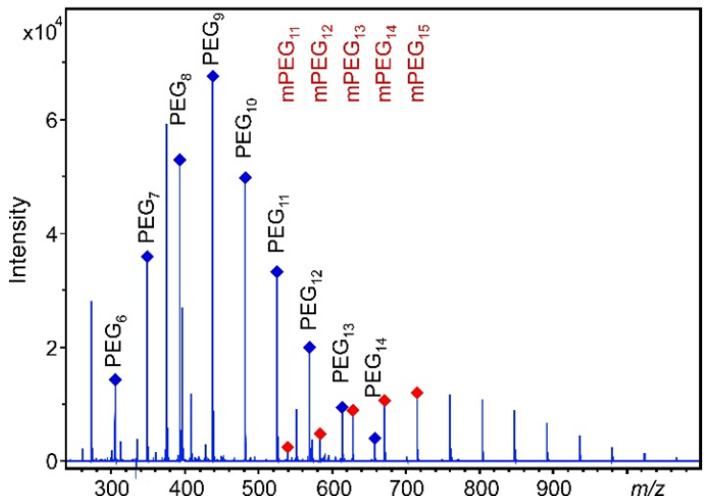
Figure 3. MALDI-TOF spectrum of a pre-dose human urine sample spiked with PEG 400 at 0.900 mg/mL and 50 µL of mPEG. The peaks marked by red symbols denote the mPEG oligomer series.